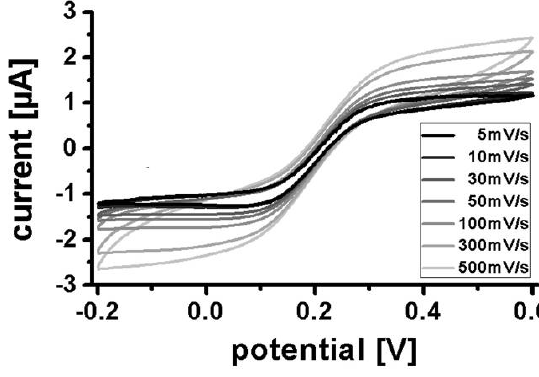
Figure 5. Cyclic voltammograms of 10 mM potassium ferrocyanide/10 mM potassium ferricyanide in 0.1 M potassium phosphate buffer using an array of 10 tubular PEDOT ultramicroelectrodes of diameter 100 µm, a PEDOT counter electrode, and a Ag|AgCl|3M NaCl reference